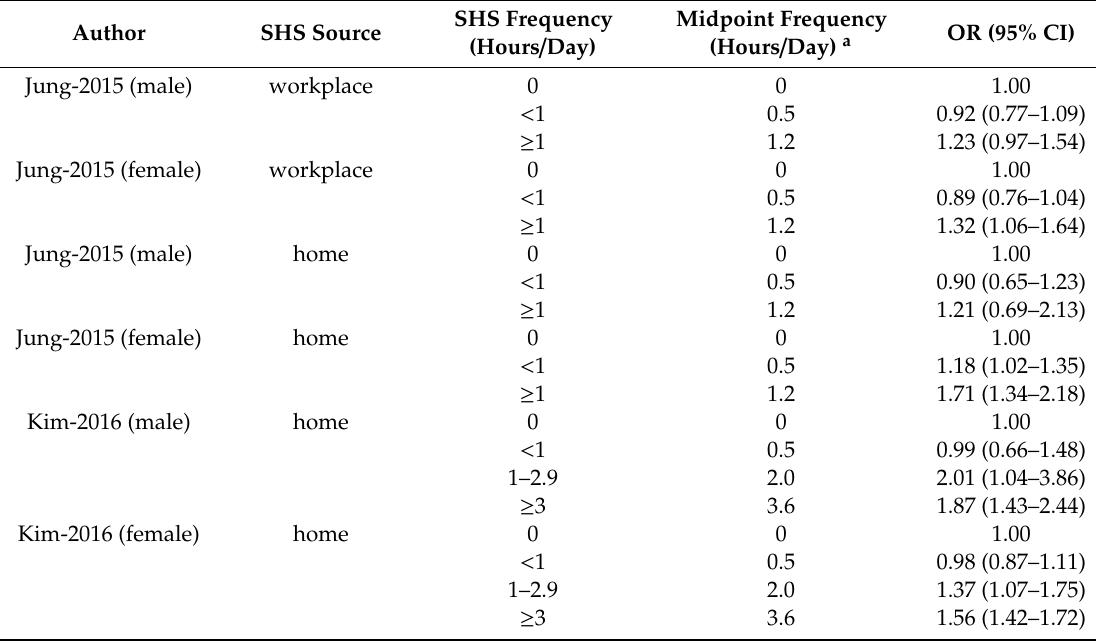
Table 3. Epidemiological studies of frequency of SHS exposure (hours / day) and depressive symptoms.